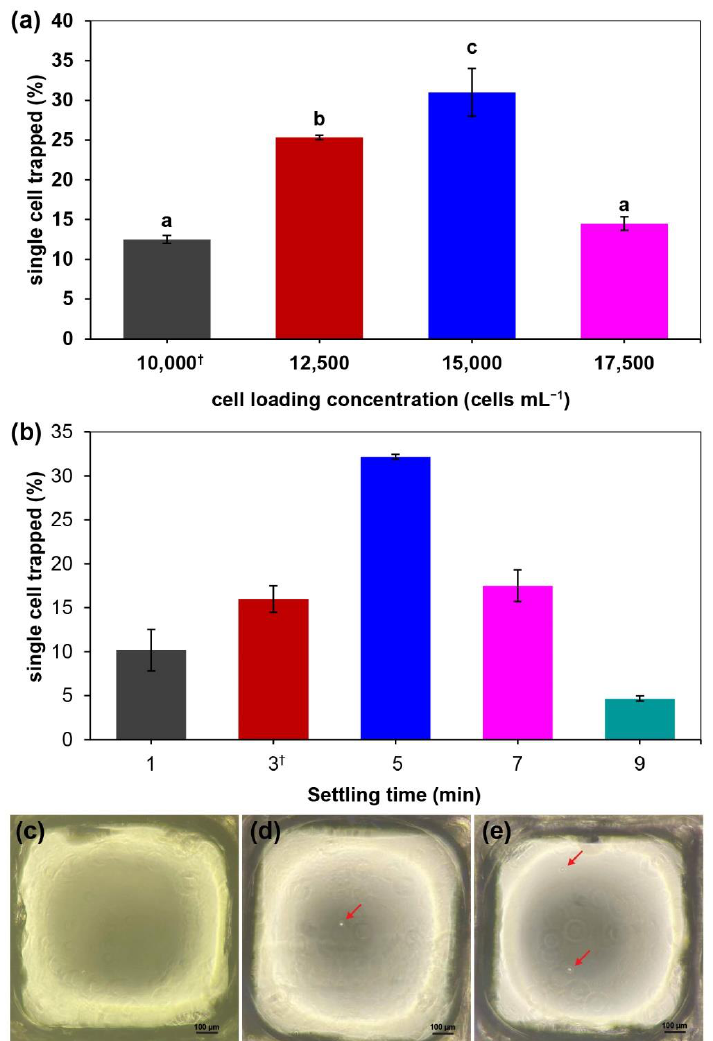
Figure 3. Average single-cell trapping using the MBM microfluidic device with optimization of ( a ) cell loading concentration (cell mL − 1 ) and ( b ) the settling time (min). Images of the MBM’s wells with ( c ) no-CHO cell trapping, ( d ) a single-CHO cell trapping, and ( e ) multi-CHO cell trapping. Red arrow indicates CHO cells. Scale bars represent 100 µ m. Experimental data are reported as mean ± standard deviation ( n = 3), with † corresponding to the control. Means followed by the different letters within columns indicate a significant difference at p < 0.05 using Duncan’s multiple range